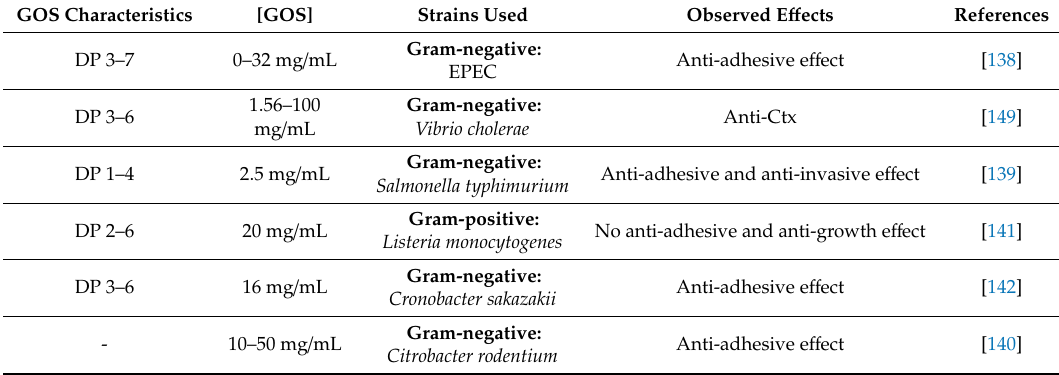
Table 5. Overview of the anti-pathogenic functionalities of